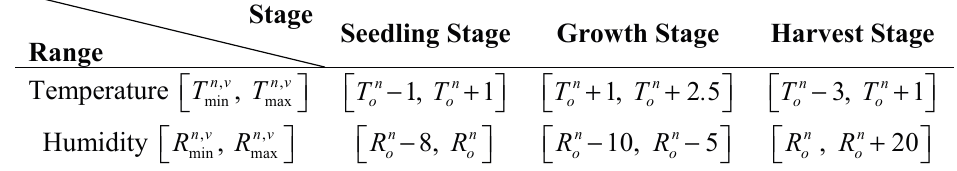
Table 4. Target temperature and humidity range corresponding to various growth